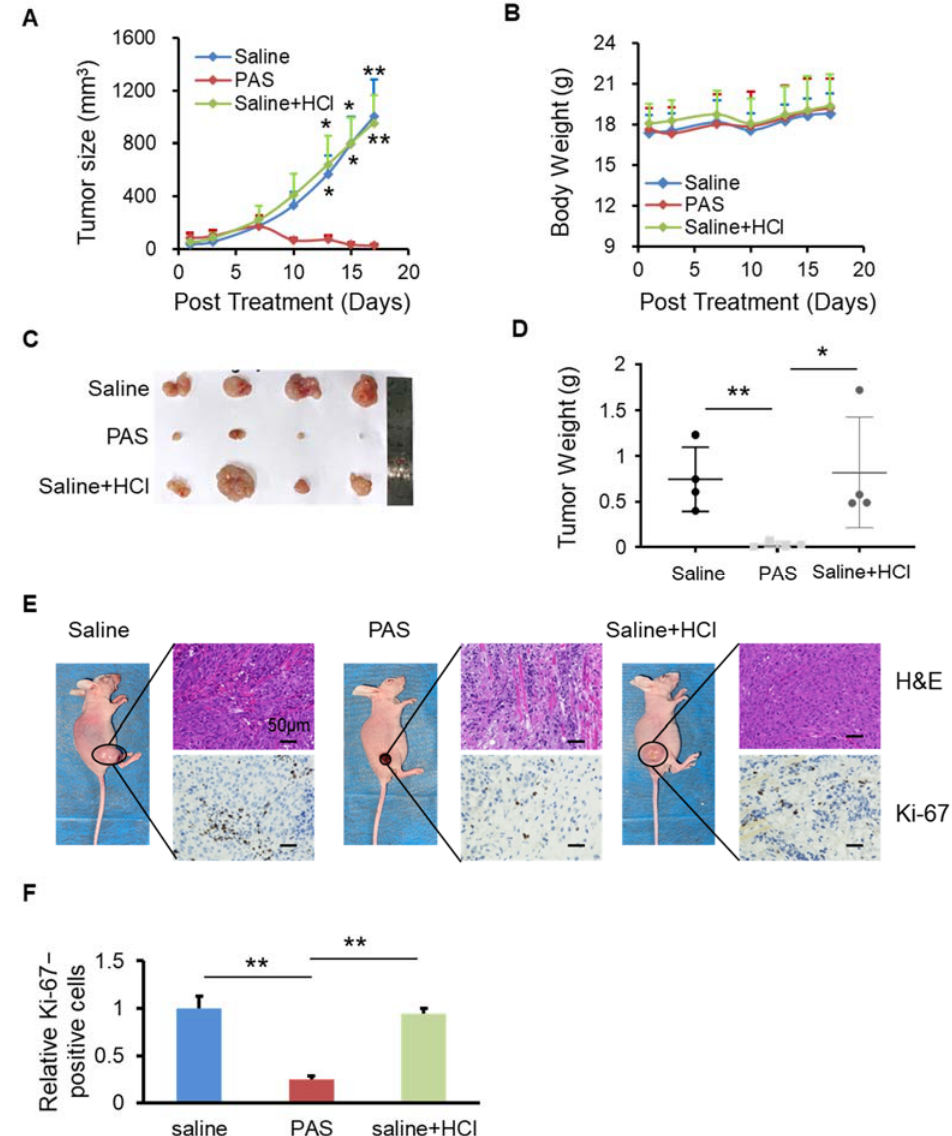
Figure 3. PAS injection suppressed cell growth that was independent of the pH value. Nude mice bearing A375 xenografts were grouped and treated with saline, PAS, or HCl used to adjust saline pH to 2.5. The tumor size ( A ) and body weight ( B ) were measured. After euthanasia, tumors were harvested ( C ) and weighed ( D ). Tumor sections stained with H&E (upper panel) and Ki-67 (lower panel) ( E ). ( F ) Quantitative analyses of Ki67-positive cells were performed with ImageJ. Data represent the mean ± SD; n = 4; * p < 0.05; ** p < 0.01; scale bar = 50 μ m.